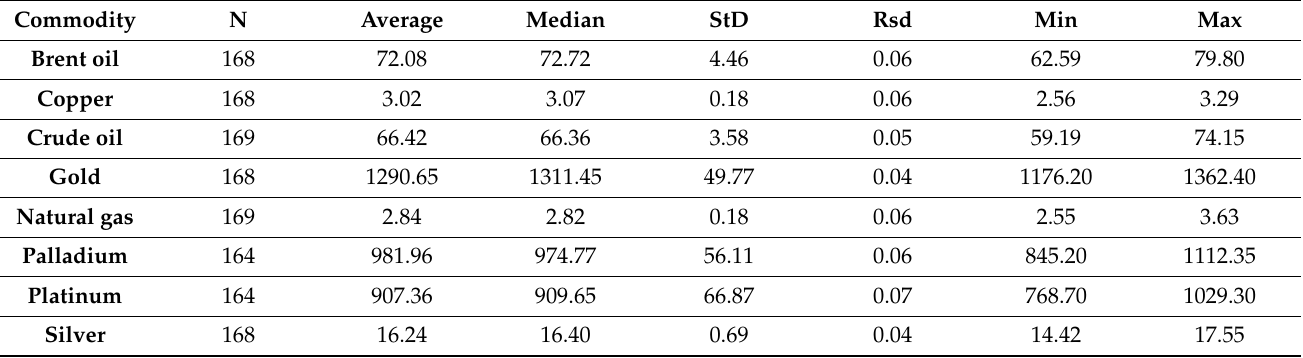
Table 7. Descriptive statistics of variables (1 January 2018–31 August 2018).